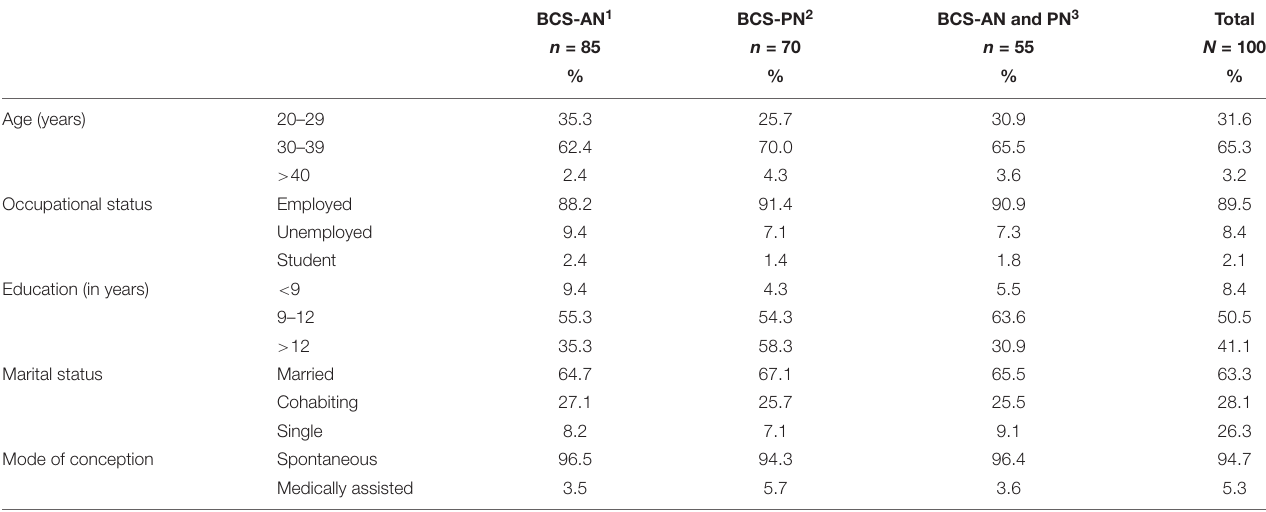
TABLE 1 | Sociodemographic characteristics of